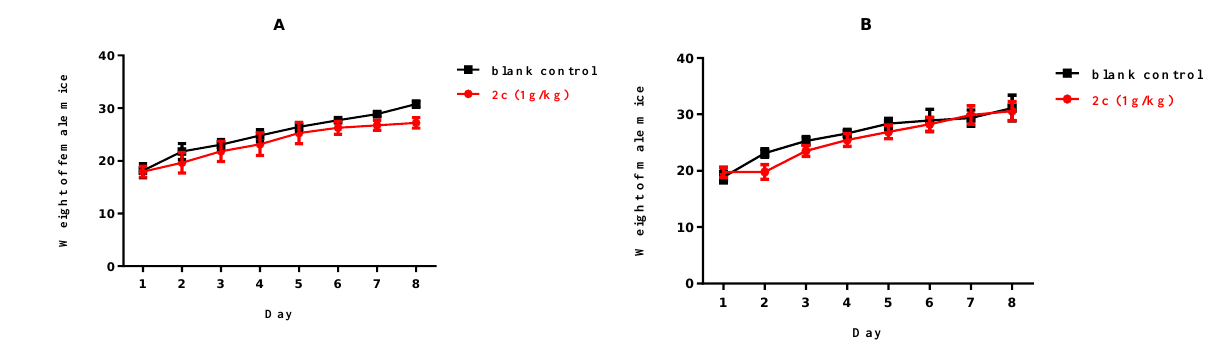
Figure 6. Body weight of ( A ) female mice (g) and ( B ) male mice (g) versus time (day).